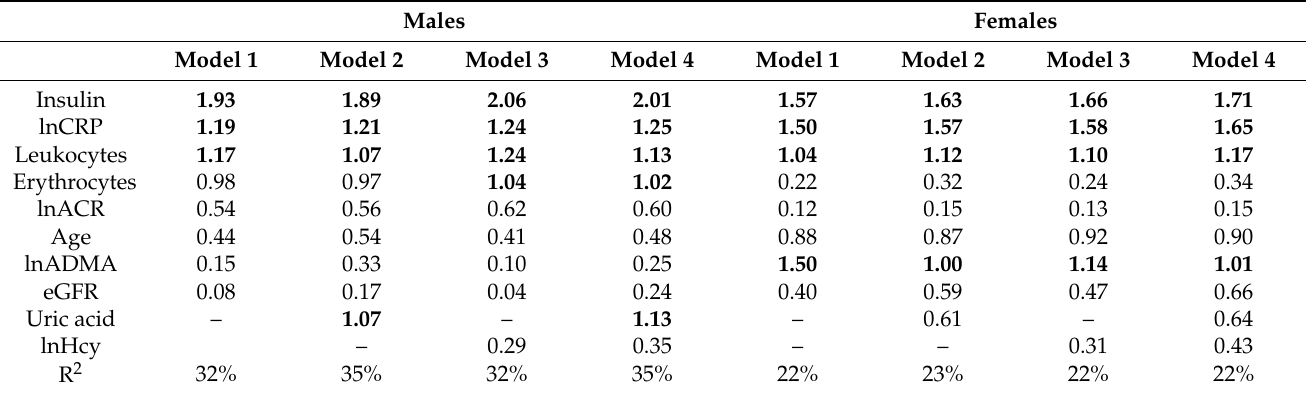
Table 4. Multivariate regression of uric acid, homocysteine, and cardiometabolic risk factors and markers on continuous metabolic syndrome score using the orthogonal projections to latent structures model in males and